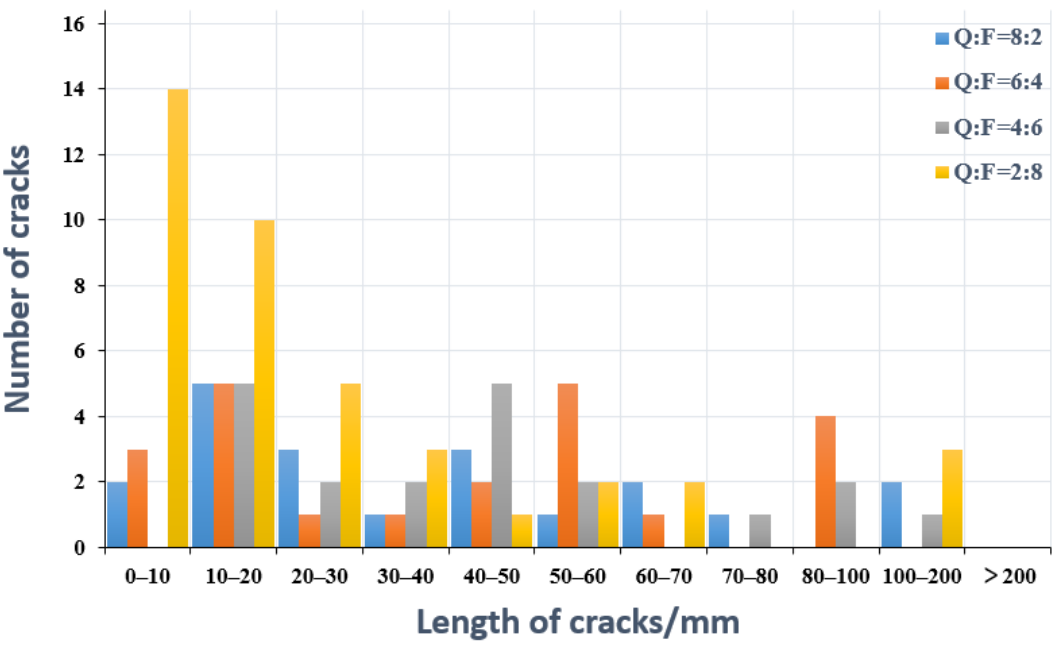
Figure 11. Distribution of crack length in samples with different Q:F.